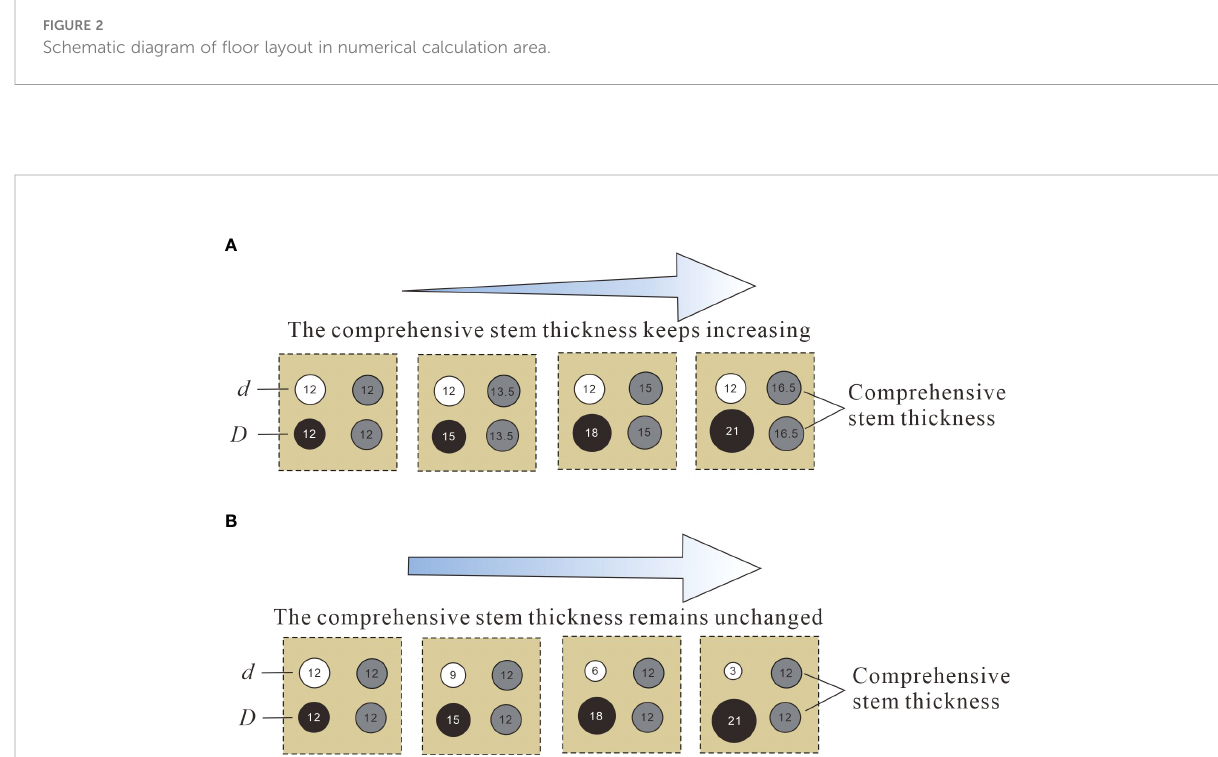
FIGURE 3 Creative diagram of the distributions of two different vegetation combinations. (A) Vegetation combination distribution, (B) Vegetation discrete distribution.